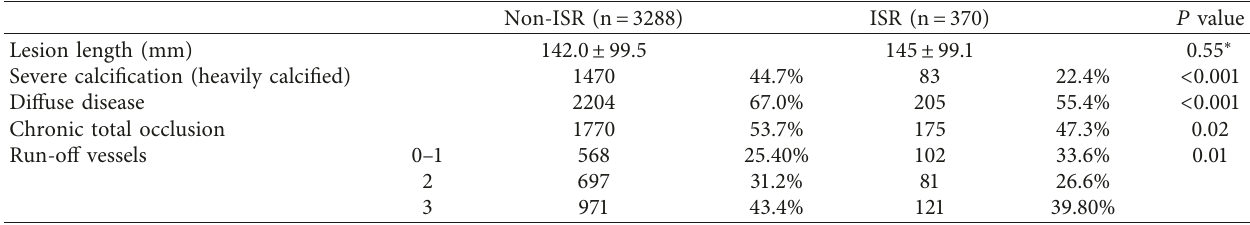
Table 2: Target lesion characteristics for femoropopliteal (FP) non-in-stent restenosis and in-stent restenosis (ISR) groups.